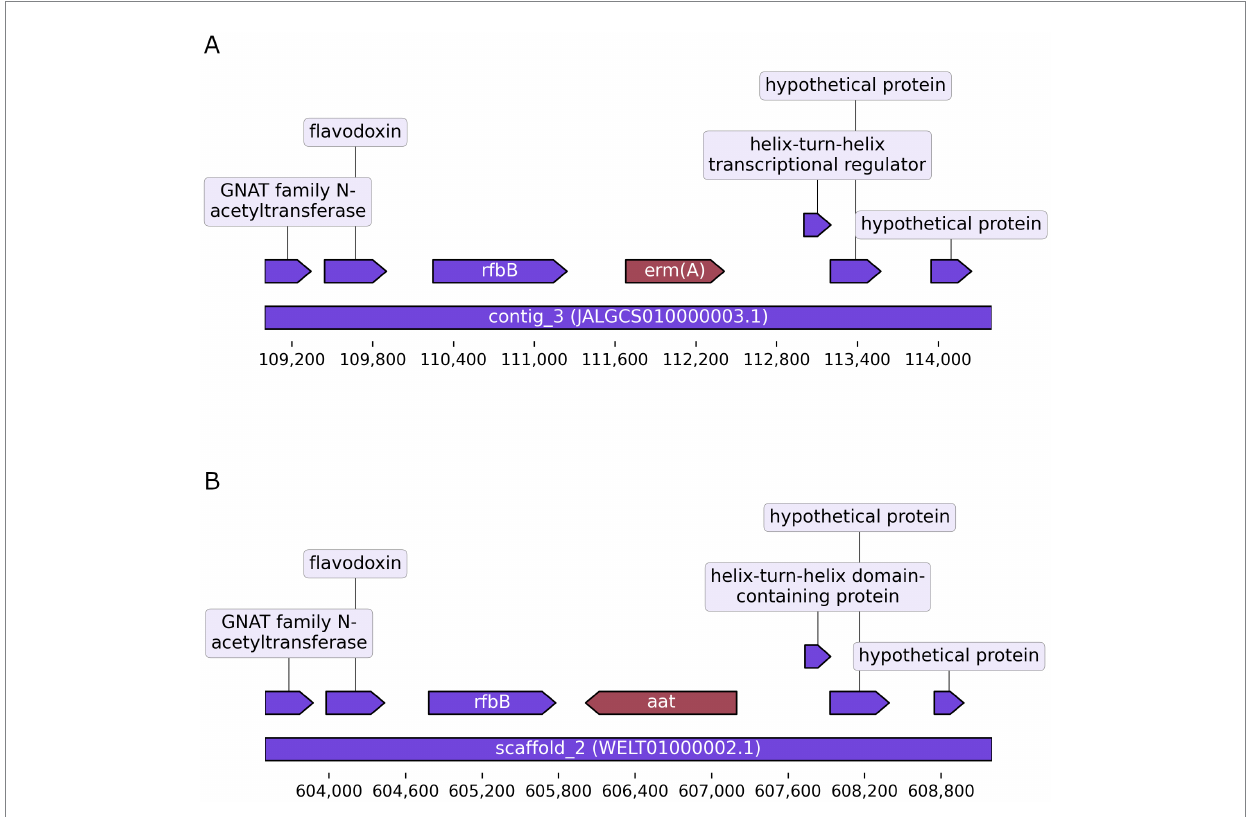
FIGURE 2 Gene replacement in Pediococcus acidilactici. The illustration shows the erm(A) gene that replaced the aat gene in the knockout strain (A) . The corresponding region containing the aat gene in the wild-type strain is shown in the lower panel (B) . Arrows represent protein-coding sequences. The rulers indicate the location in contig_3 (GenBank acc. no. JALGCS010000003.1) and chromosome (GenBank acc. no.